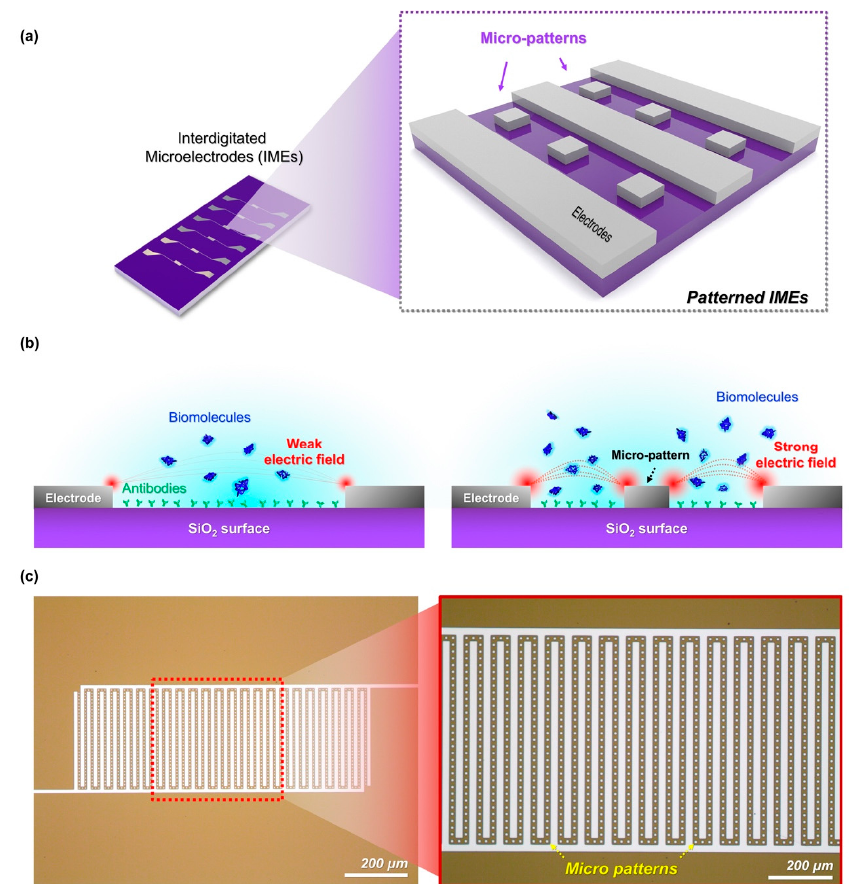
Figure 1. Highly sensitive electrical sensor with enhanced concentration effect of dielectrophoresis (DEP). ( a ) The patterned interdigitated microelectrodes (IMEs) have repetitive square microstructures between the IMEs, ( b ) reaction between the target molecules and their specific antibodies immobilized on the SiO 2 surfaces of the bare IMEs (left) and the patterned IMEs (right), and ( c ) fabricated IMEs with micropatterns using MEMS technology.